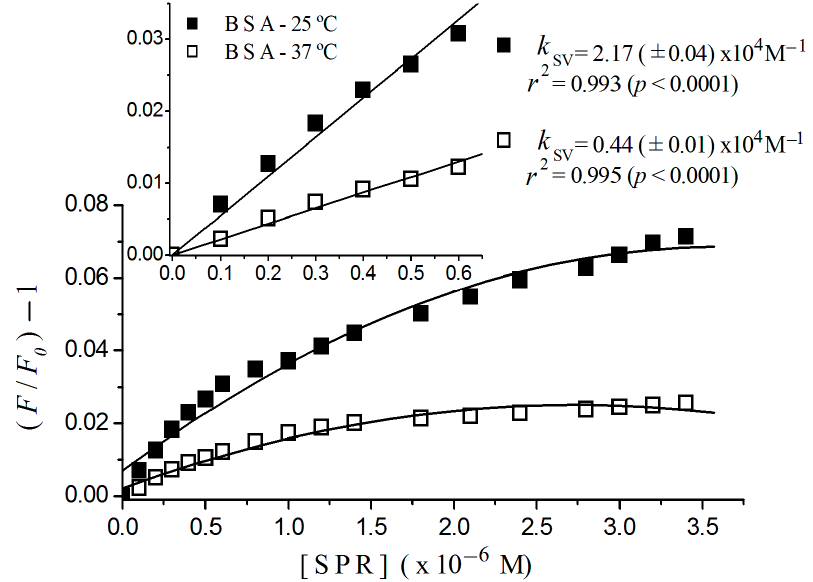
Figure 3. Stern-Volmer plots of BSA titrated with sulpiride at 25 and 37 °C. Excitation λ = 290 nm; (albumin) = 2 × 10 − 6 M; 10 − 3 M phosphate buffer, pH 7.4, [SPR] = sulpiride concentration. Detail shows plot region for low sulpiride concentration region, with regression coefficient and Stern-Volmer constant estimated for this region.